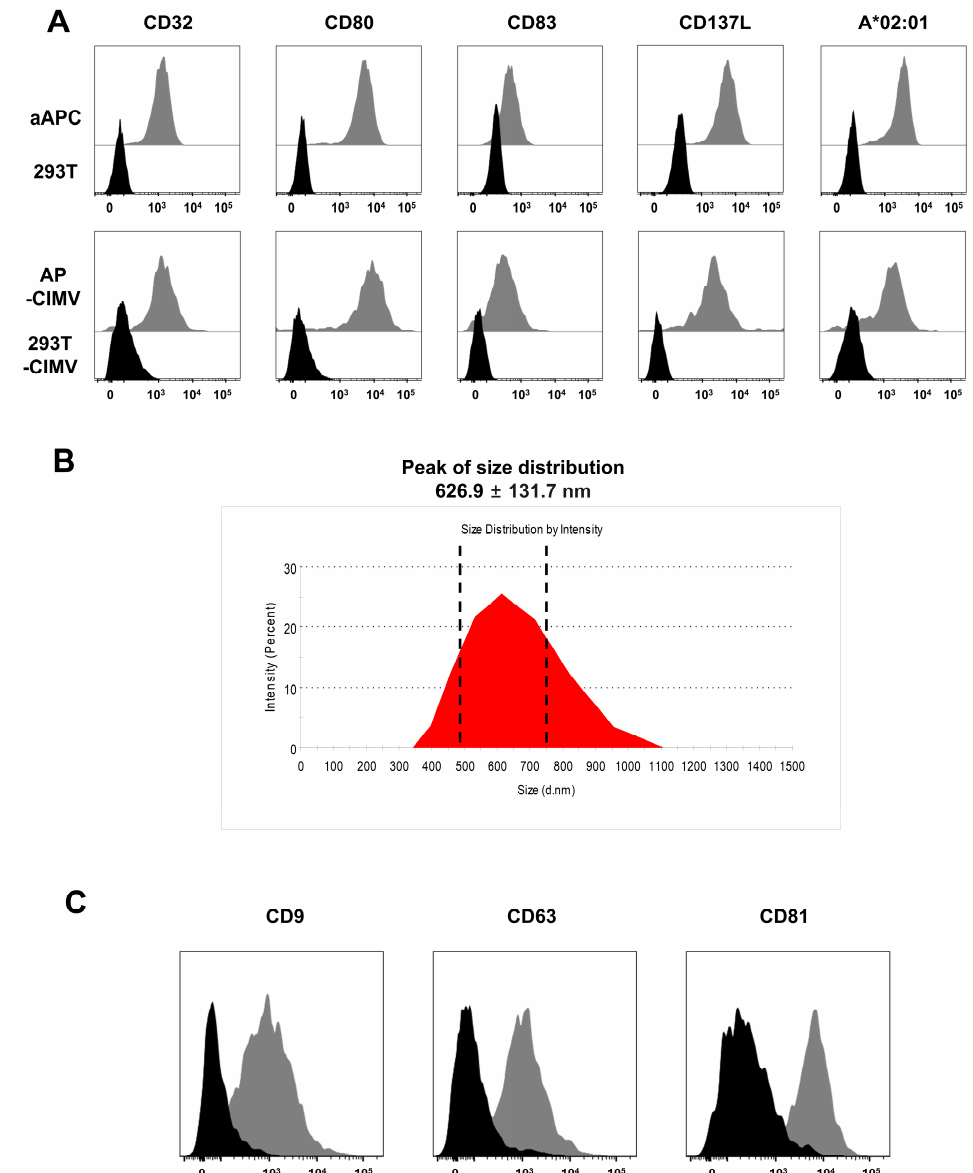
Figure 2. Characterization of AP-CIMVs generated from aAPC expression co-stimulatory molecules and HLA-A*02:01. ( A ) The expression of CD32, co-stimulatory molecules (CD80, CD83, and CD137L) and HLA-A*02:01 on the surface of aAPCs and AP-CIMVs was analyzed via flow cytometry. ( B ) The size of AP-CIMVs was measured via Zetasizer Nano ZS. Majority of the size was confirmed at 626.9 ± 131.7 nm. ( C ) The expression of extracellular vesicle markers (CD9, CD63, and CD81) on the surface of AP-CIMVs was analyzed via flow cytometry. Black histograms indicate isotype control, and gray histograms indicate anti-CD9, CD63, or CD81 stained